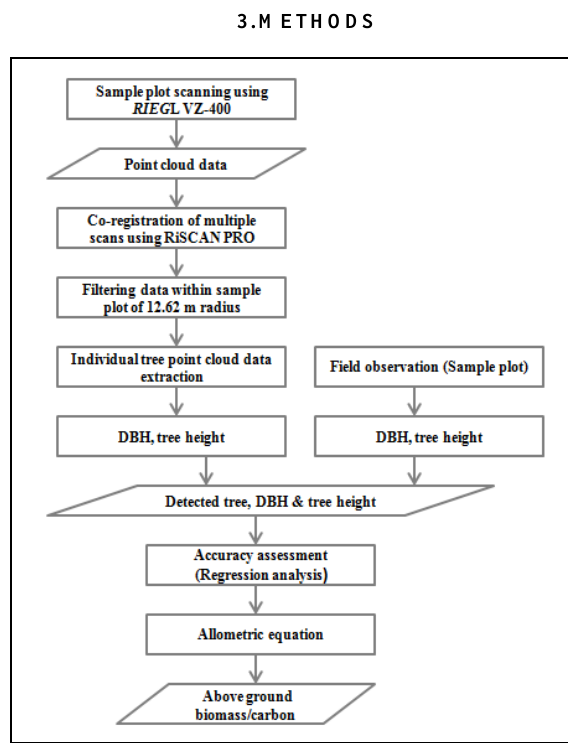
Figure 2. Flow diagram of research methods